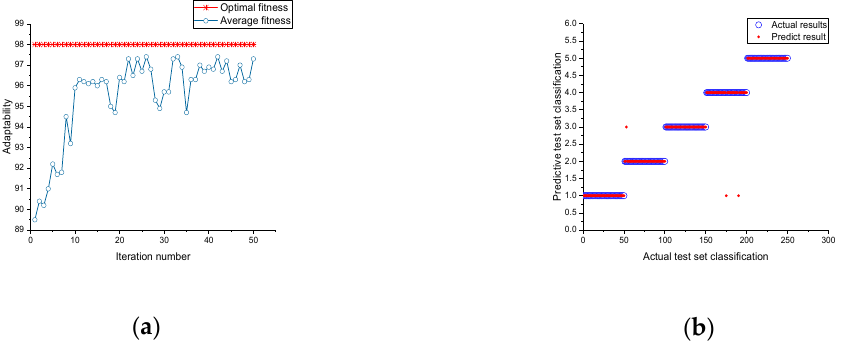
Figure 14. PSO iterative optimization and final results. ( a ) Iterative optimization process, ( b ) Final classification results.